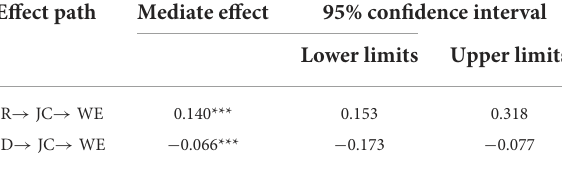
TABLE 5 Bootstrapping test results of mediating